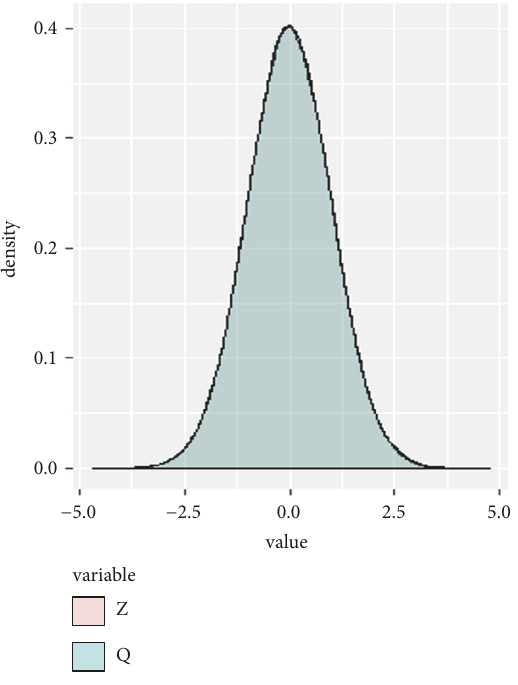
Figure 5: Kernel density plot of 𝑍 and 𝑄 at 𝑛 = 3 , 𝑇 = 𝐸𝑅𝑆𝑆 , and 𝜌 = 0.75 𝑋𝑌